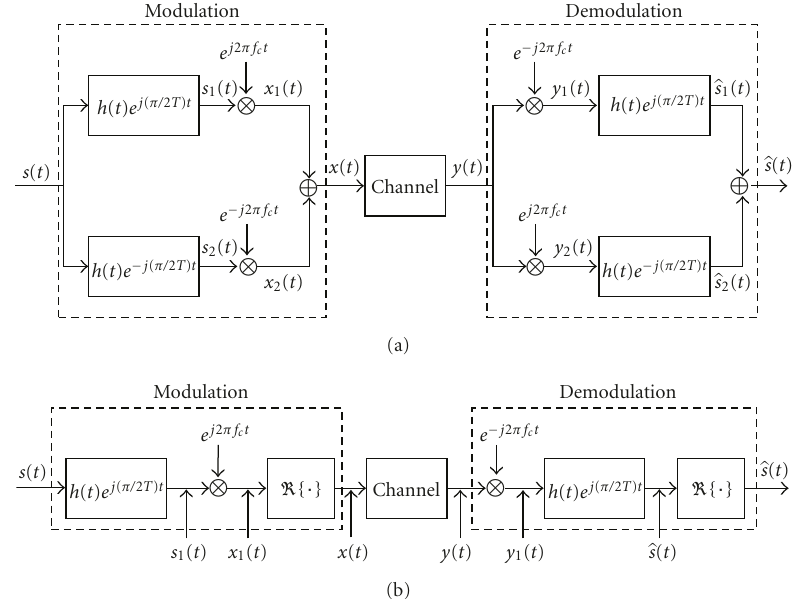
Figure 3: Vestigial side-band modulation and demodulation. (a) Detailed block diagram. (b) Simplified block